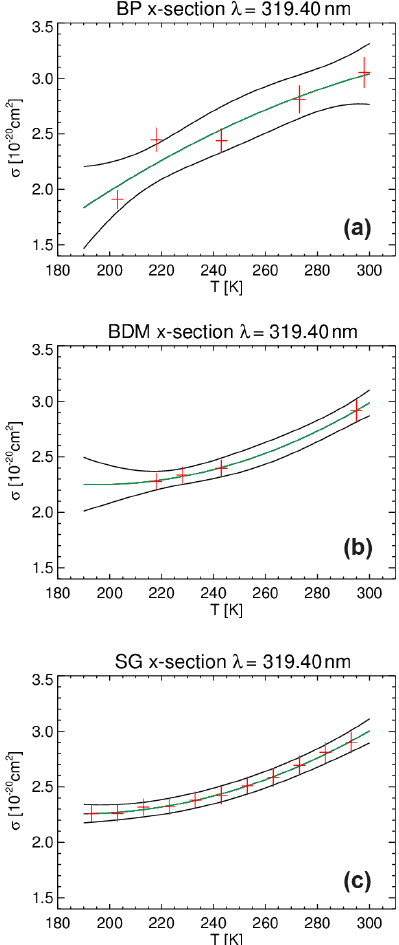
Figure 7. Same as Fig. 6, but at